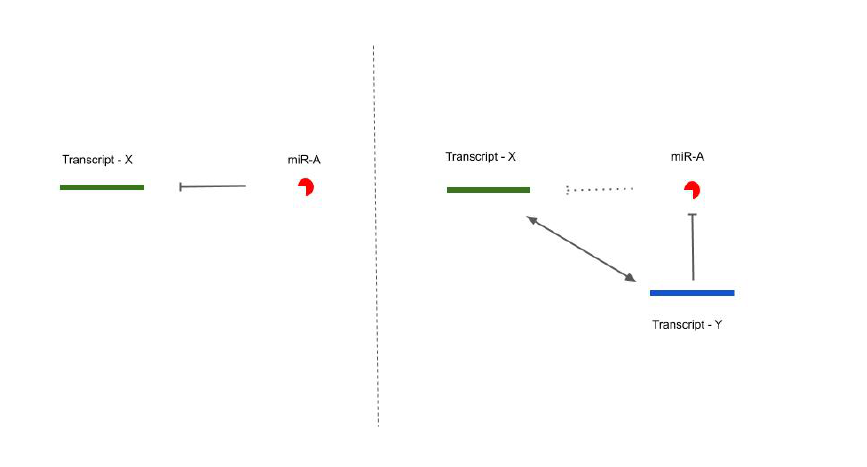
Figure 2. Left panel : A naive situation with one miRNA: miR-A, and one target: transcript-X. Transcript-X harbors miR-A microRNA response elements (MREs) and can be post-transcriptionally regulated by miR-A. Right panel : In the same situation, a new miR-A target is added, transcript-Y. Transcript-Y harbors itself miR-A MREs and can sponge miR-A, thus leading to a reduced post-transcriptional regulation of transcript-X by miR-A through an indirect